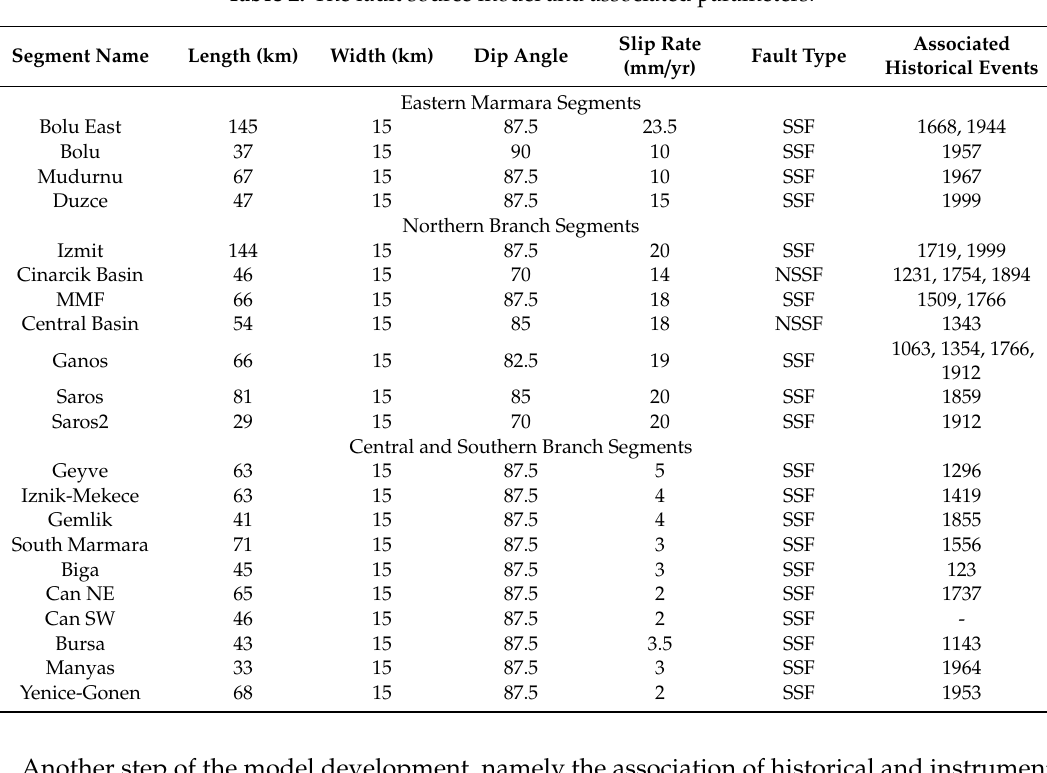
Table 2. The fault source model and associated parameters.